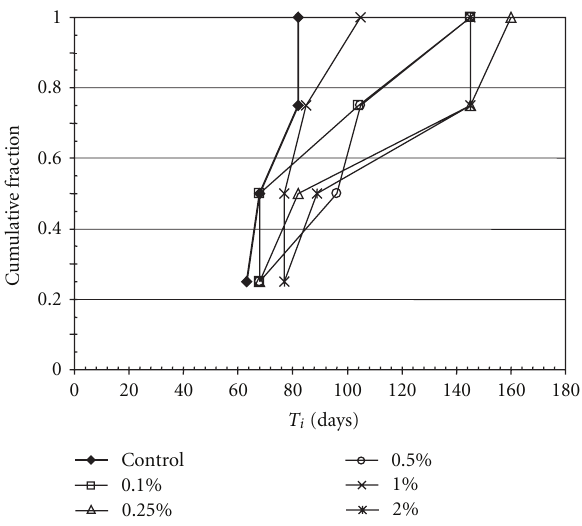
Figure 5: Cumulative fraction of the time of corrosion initiation ( T i ) for all SP electrochemical